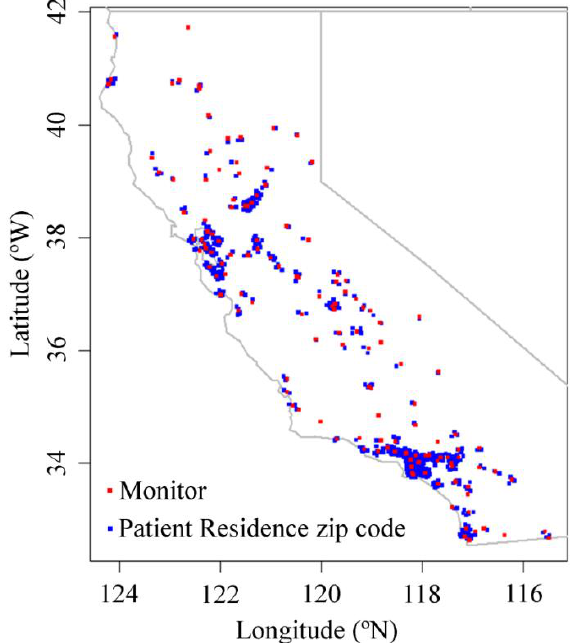
Figure 1. Fine particulate (PM 2.5 ) monitor and patient resident zip code locations for California,